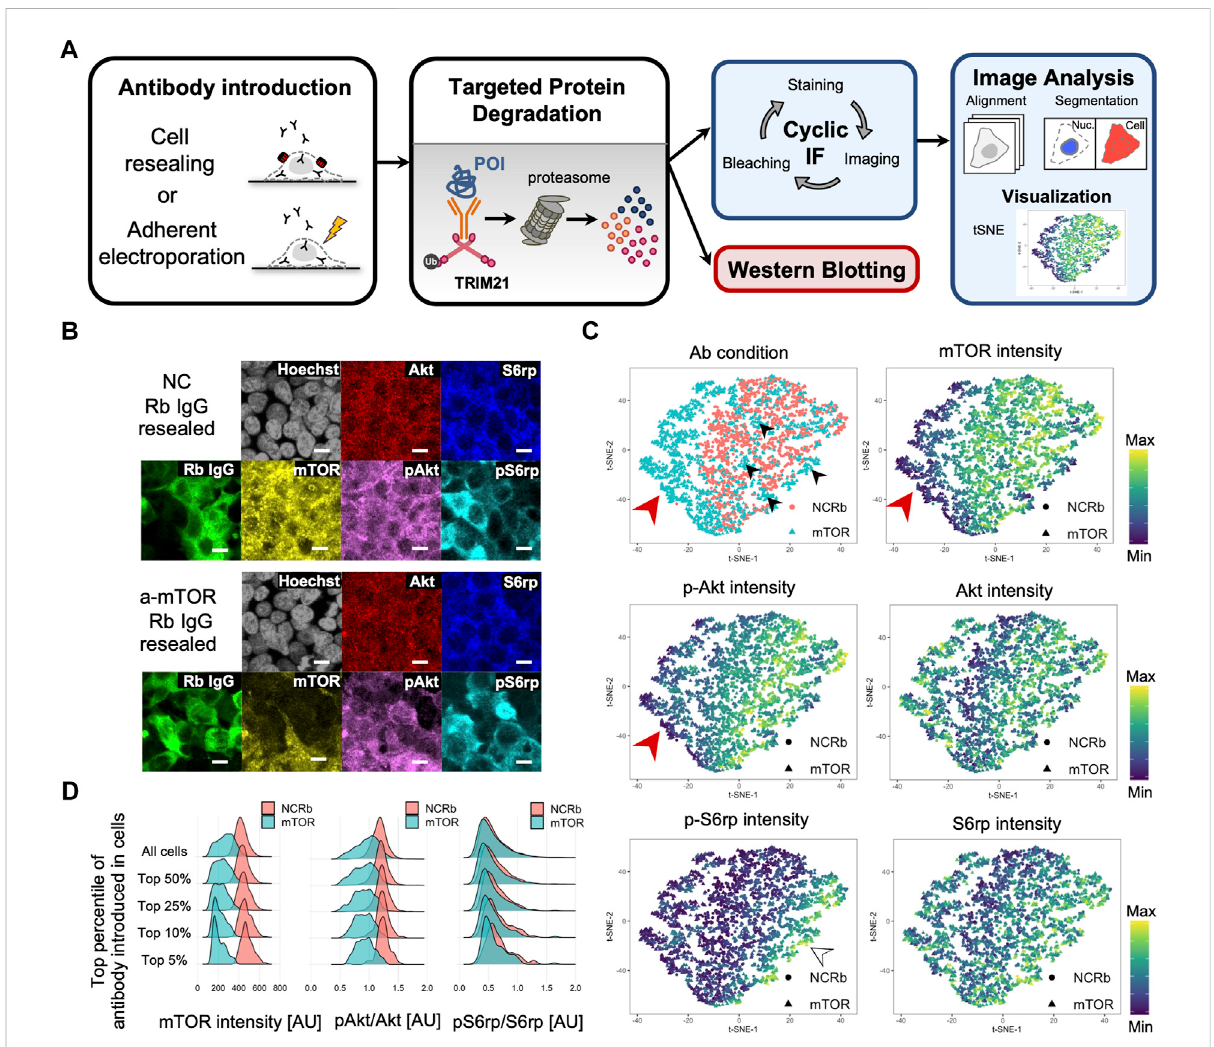
FIGURE 6 Single-cell analysis of cell resealing-mediated Trim-Away targeting mTOR. (A) Outline of the Trim-Away experiment followed by cyclic immuno fl uorescence and single-cell analysis. First, Trim-Away was performed with TRIM21-overexpressed Piranha TM HEK293T cells grown on 96- well plates by introducing anti-protein of interest antibodies. After incubation, the cells were fi xed, permeabilized, and stained with the fi rst set of antibodies, after which they were automatically imaged using an A1 confocal microscope and NIS-Elements software. After imaging, the cells werebleachedusinghydrogenperoxide,highpH,andlightexposure,andasecondroundofstainingwasconducted via directimmuno fl uorescence using Alexa Fluor-labeled antibodies. After repeated rounds of immuno fl uorescence staining, imaging, and bleaching, all images were aligned and analyzed.ForthemTORTrim-Awayexperiment,threecyclesofcyclicimmuno fl uorescencewereperformed:DAPI,rabbitantibody(mTORantibody or normal rabbit antibody), and S6rp were stained for the fi rst cycle; DAPI, phosphorylated S6rp, and mTOR were stained for the second cycle; and DAPI, Akt, and phosphorylated Akt were stained for the third cycle. Mean intensities of mTOR, phosphorylated Akt, Akt, phosphorylated S6rp, S6rp, rabbit antibody (mTOR antibody or normal rabbit antibody), and Hoechst were quanti fi ed per cell using confocal images. (B) Confocal microscope imagesofTRIM21-overexpressedPiranha TM HEK293Tcellsthatwereresealedwithanti-mTORantibody(clone7C10,CST,Cat#2983BF)orthesame amount of normal rabbit antibody as a negative control (NC). Cells were incubated for 12 h and underwent the cyclic immuno fl uorescence procedure outlined in (A). Cells with anti-mTOR antibodies tended to have lower levels of mTOR and phosphorylated Akt. Scale bar: 10 μ m. NC: negative control, Rb: rabbit. (C) Single-cell multidimensional data were visualized using the dimensionality reduction algorithm t-distributed stochastic neighborembedding(t-SNE). Thetopleftpanel iscolor-codedbytheantibodyconditionofeachcell,i.e., anti-mTORantibodyornormal rabbit IgG (NCRb); a distinguishable domain consisting of anti-mTOR antibody-resealed cells is shown on the left (see the red arrowhead). All other maps are color-coded by the mean intensity of the respective proteins. The mTOR map (top right panel) and pAkt map (middle left panel) showed similar fl uorescenceintensitypatterns,indicatingthatcellswithhighlevelsofmTORhadhighlevelsofphosphorylatedAkt. (D) Densityplotsshowing mTOR intensity, pAkt/Akt, and pS6rp/S6rp of cells resealed with mTOR or normal rabbit IgG (NCRb). Single-cell data were fi ltered by the top percentile of the fl uorescence intensity of the introduced antibody. The difference in distribution between anti-mTOR-resealed cells and the negative control became more pronounced as the data were narrowed down to the most ef fi ciently resealed cells. AU: arbitrary